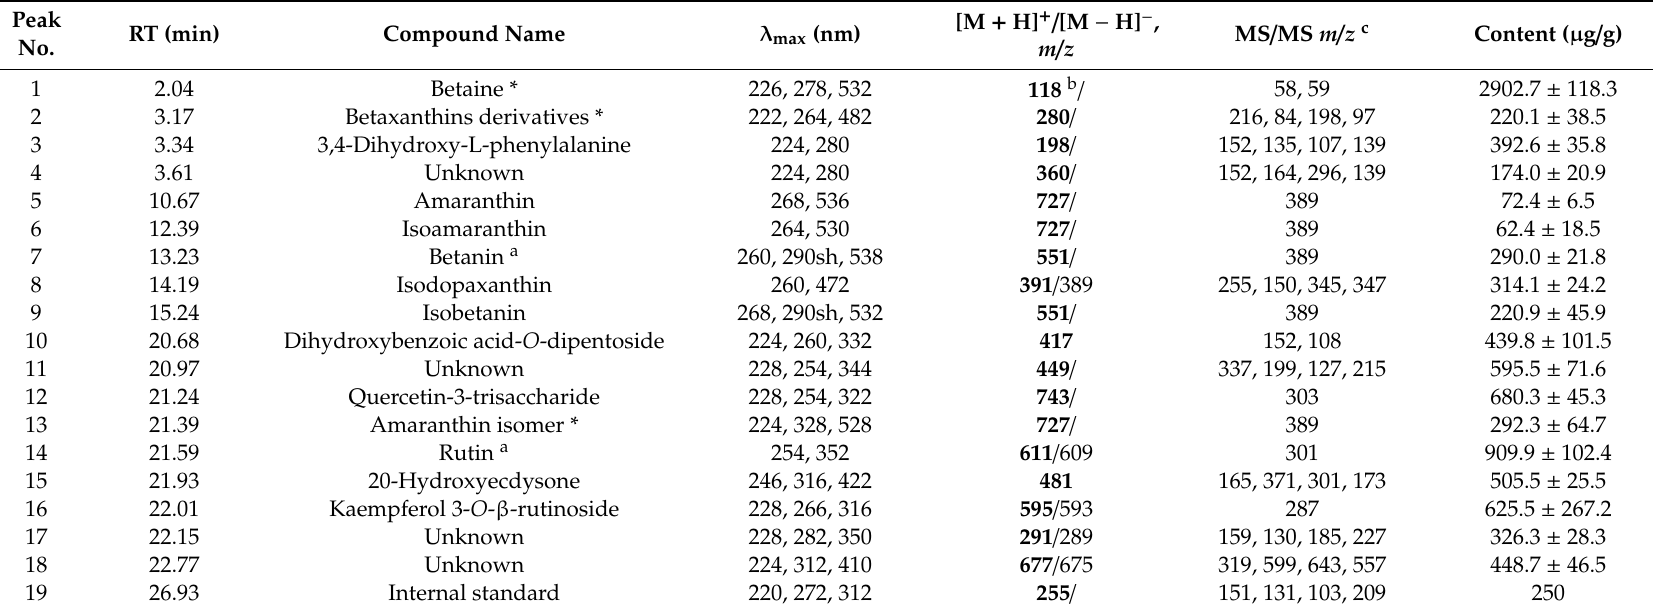
Table 1. Retention time, UV-Vis, and mass spectral characteristics of ethanolic extracts of djulis husk (EEDH).